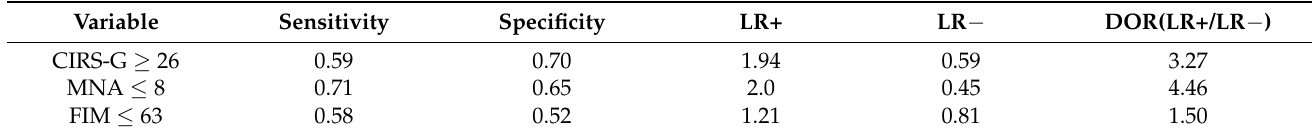
Table 3. Sensitivity, specificity, positive and negative likelihood ratio and diagnostic odds ratio (DOR) values for 1-year mortality according to CIRS-G, MNA and FIM at the best cut-off values (computed with Youden index).